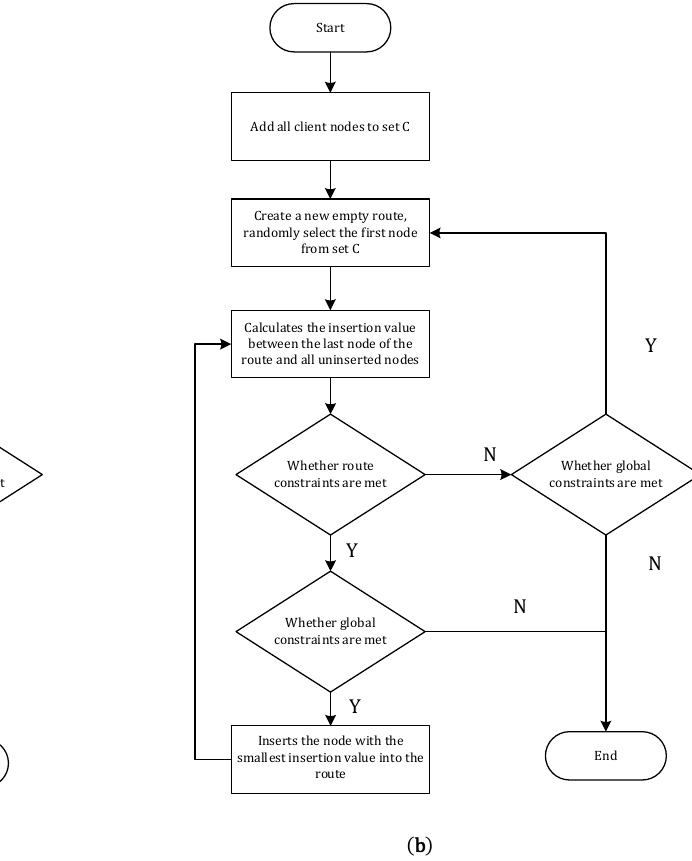
Figure 4. Flowchart of the saving algorithm and nearest neighbor insertion algorithm. ( a ) The flowchart of improved CW saving algorithm; ( b ) the flowchart of nearest neighbor insertion algorithm.